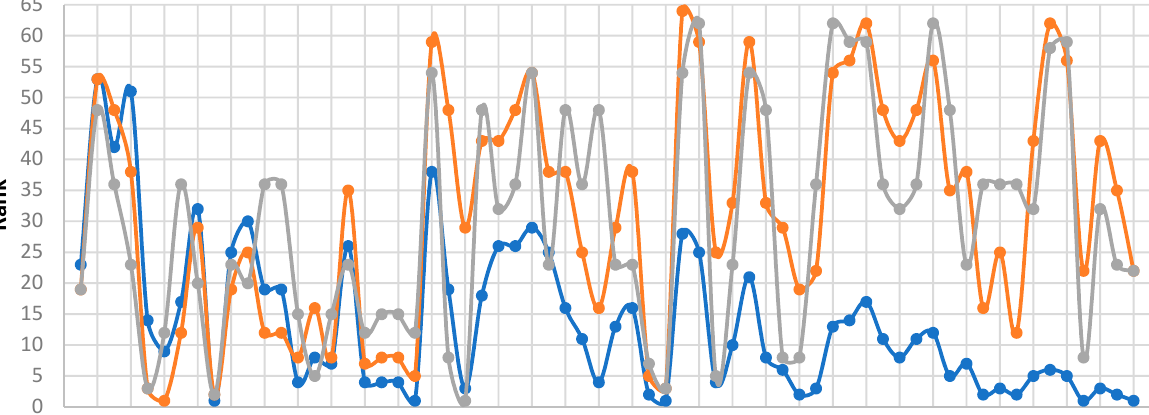
Figure 9. Diagram of the distribution of the impact of risk factor on the duration by ranks.